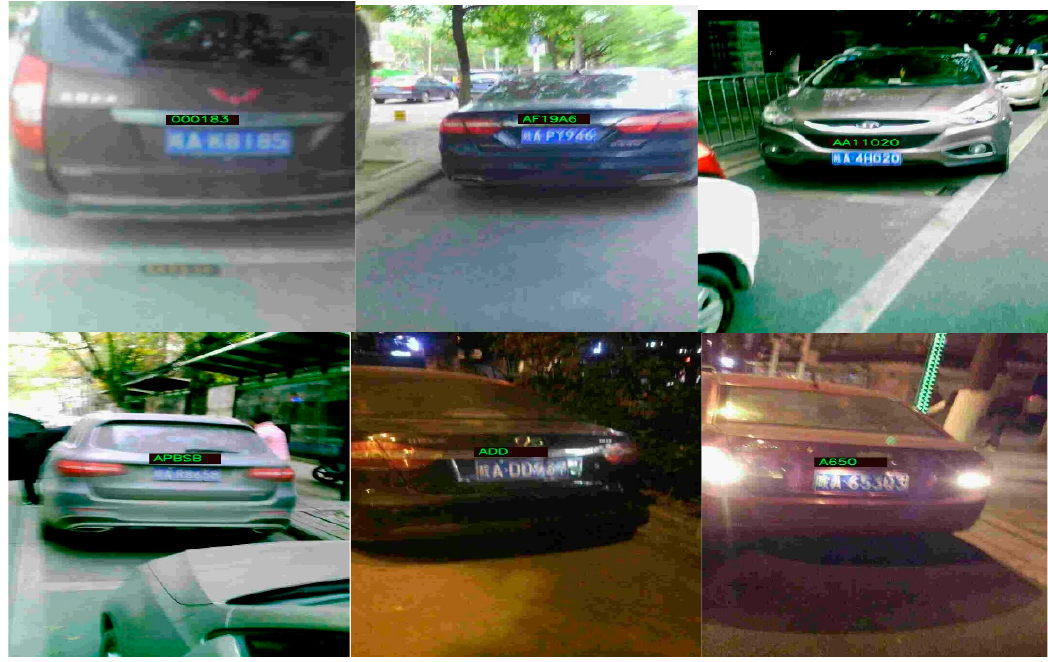
Figure 10 . Few failures cases